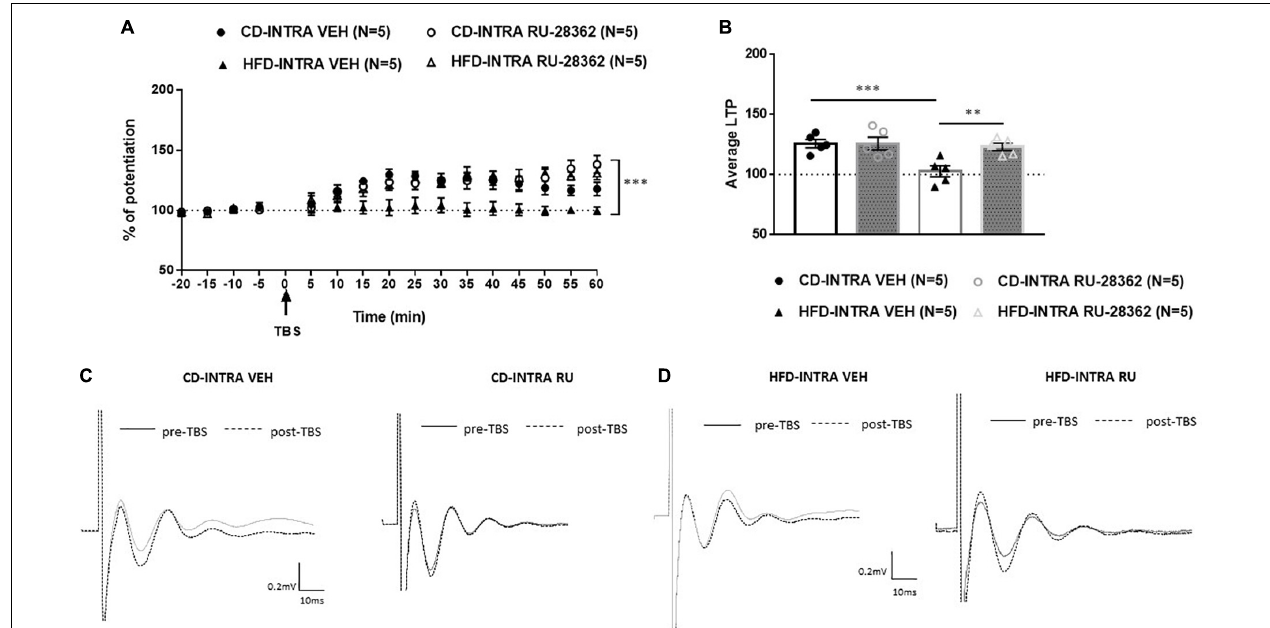
FIGURE 9 | Effects of intra-mPFC GR activation on prefrontal LTP in HFD- and CD-fed adults. (A) Normalized fEPSPs recorded in vivo before and after TBS of the BLA-mPFC pathway. Each data point shows the average fEPSPs of the preceding 5 min. (B) Average LTP shown in panel A over the 60 min after TBS. (C,D) Representative average waveforms before and after TBS Horizontal bar = 10 ms; vertical bar = 0.2 mv. For adult animals locally, microinjected with GR agonist RU-28362 or vehicle 30 min prior to TBS. Agonist treatment rescued HFD-impaired LTP in HFD-fed animals, and had no effect on CD-fed animals. Two-way ANOVA with repeated measures on the 12 post-TBS time points showed significant effects of Diet ( ∗ p < 0.05), Drug ( ∗∗∗ p < 0.005), and Diet × Drug interaction ( ∗∗ p < 0.01). Post hoc comparisons showed significant differences between RU-28362 and vehicle-treated HFD-fed animals ( ∗∗ p < 0.01), and no significant differences between CD-fed